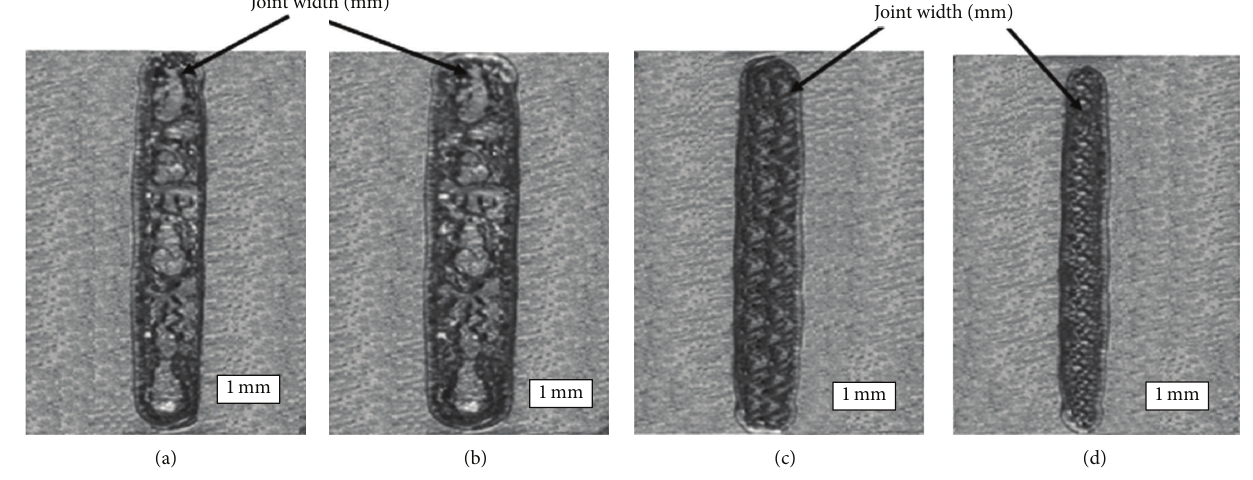
Figure 2: Macrostructure of joint seam width of 316L stainless steel and PET